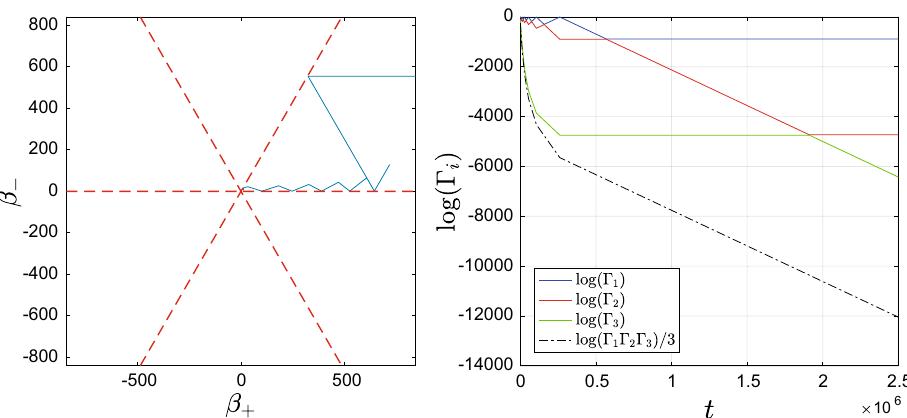
Fig. 2 Numerical simulation of the tumbling case. In the region where 0 < t < 5 × 10 5 (arbitrary units) one can see a typical Kasner era. The solution bounces in the valley formed between the curvature and one of the centrifugal potential walls. Increasing t corresponds to evolution towards the singularity